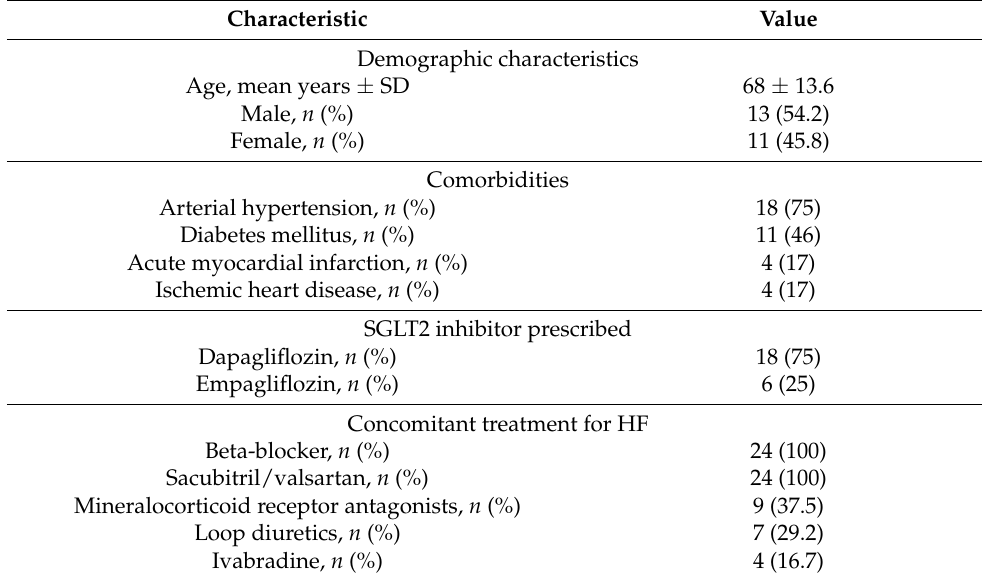
Table 1. Demographic and clinical characteristics of patients; Abbreviations: SD, standard deviation; HF, heart failure.